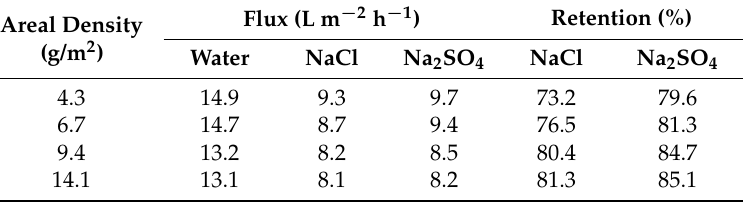
Table 5. Filtration performance of NFNFM prepared by different areal densities of HNM.